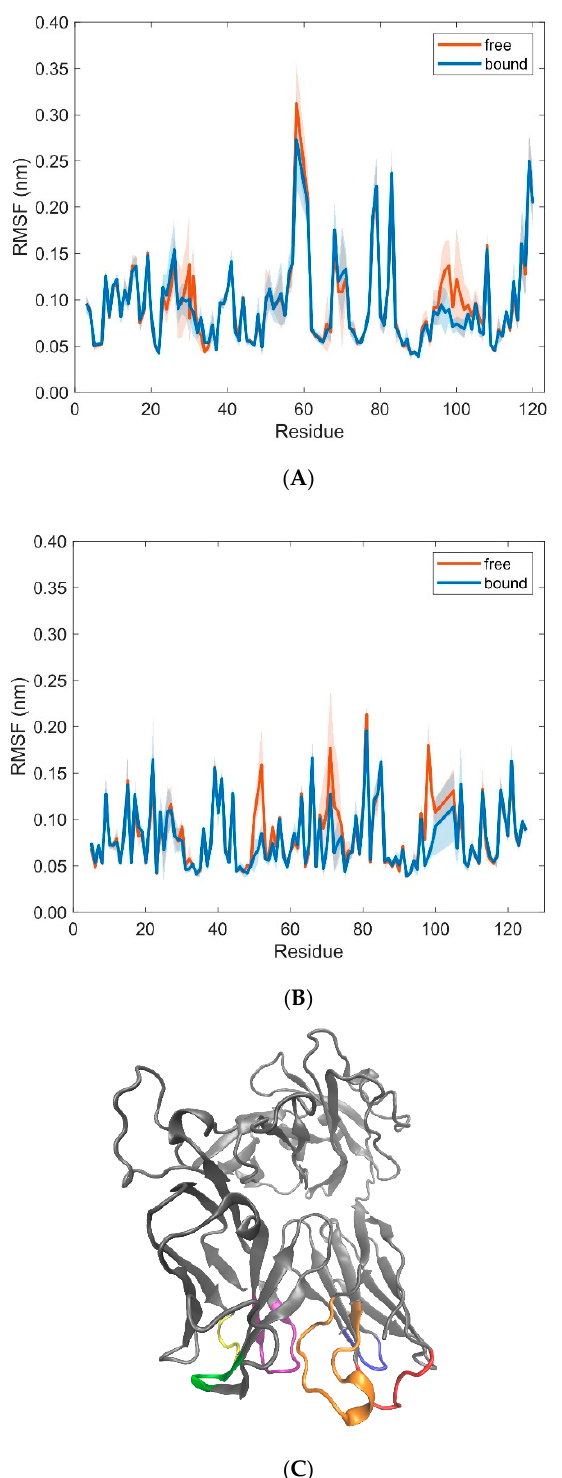
Figure 12. RMSF-values (mean ± SD) of TCR residues in the variable domains V α ( A ) and V β ( B ) in free (orange) and bound (blue) states calculated from 10 pooled 40 ns MD simulations each for unbound (free) and bound states. ( C ) Cartoon representation of the 3KPS TCR (grey) together with colored CDR loops CDR1 α (24–31, red), CDR2 α (48–55, blue), CDR3 α (93–104, orange), CDR1 β (26–31, yellow), CDR2 β (48–55, green), CDR3 β (95–107, purple) as obtained from the crystal structure of the 3KPS system. The figure in panel C was produced using VMD [22] .